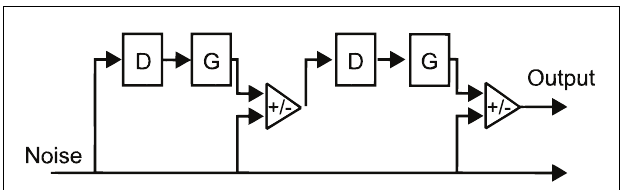
FIGURE 1 | Schematic diagram of the delay ( D ), gain ( G ), and add networks used to generate the type of IRN stimuli used in the present study (adapted fromYost, 1996). A sample of white noise is added ( G = 1) to itself following some delay.This process is repeated a number of times, and the resulting stimulus has a perceivable pitch component at the inverse of the delay (1/ D